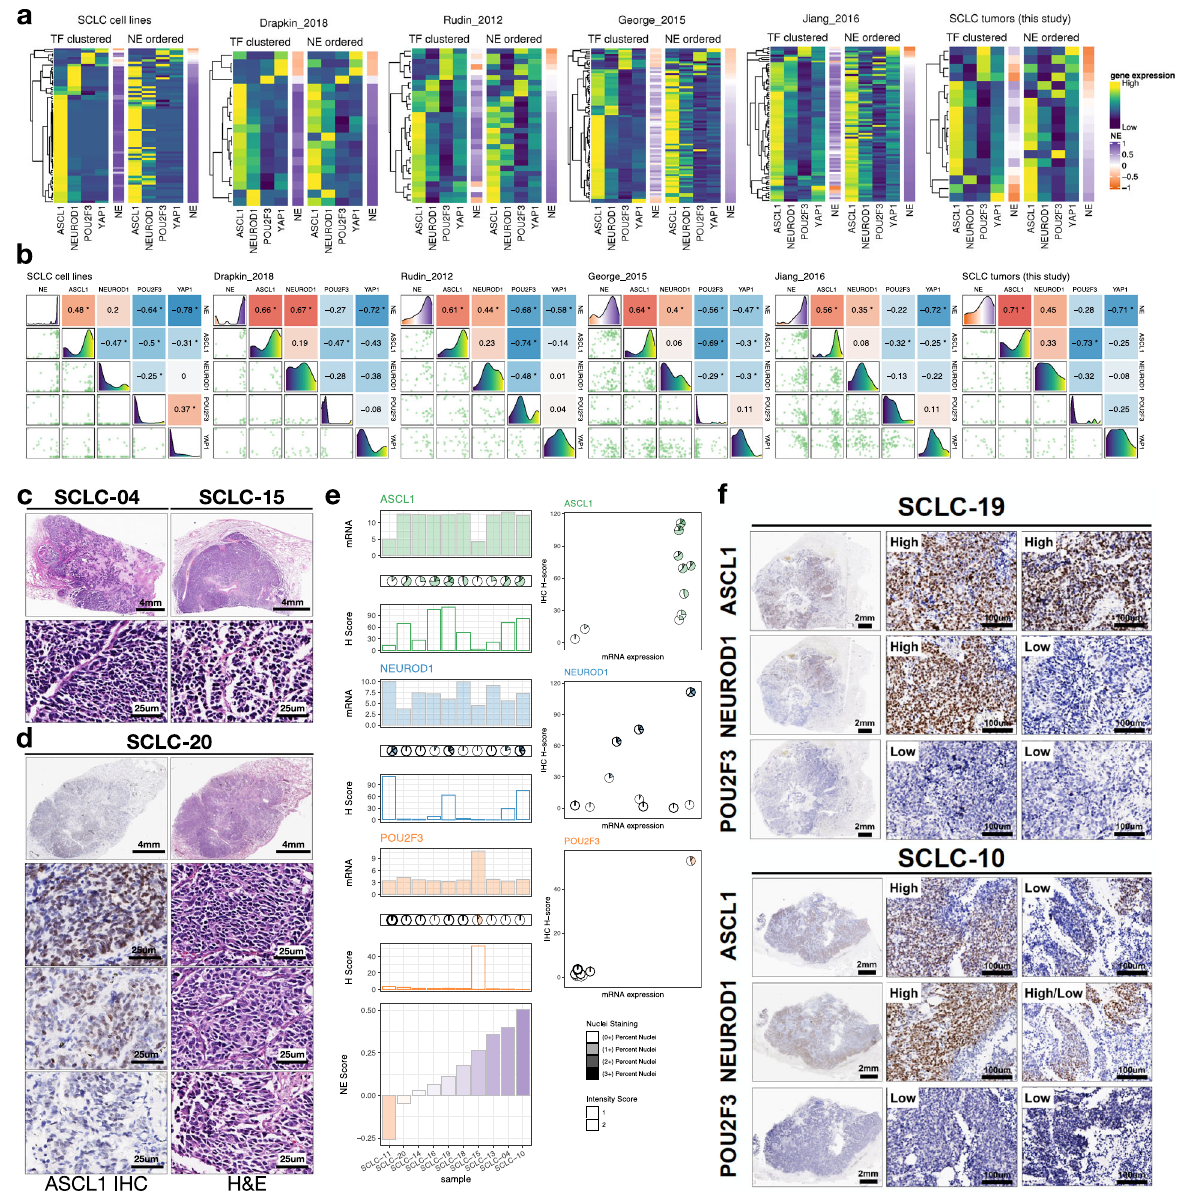
Fig. 1 NE score and SCLC molecular subtypes. a Heatmaps visualizing relative expression of molecular subtype-speci fi c TFs and NE scores. Two heatmaps were generated for each study, with one ordered by complete linkage hierarchical clustering of TFs and the other ordered by NE scores. Gene expression was z -score standardized for each sample. b Pairs plot for NE scores and molecular subtype-speci fi c TFs. Lower left panels are scatter plots showing a pairwise relationship between variables, diagonal panels are density plots showing the distribution of each variable and upper right panels are correlation coef fi cients from pairwise Pearson correlation. Refer to the top or right of each 5 × 5 matrix for subplot x or y axis variable labels. For example, for each data set, the fi rst subplot on the top row shows the distribution of NE scores from that data set, the scatterplot below it shows the relationship between NE score ( x axis value) and ASCL1 expression ( y axis value), and the Pearson correlation coef fi cient between NE score and ASCL1 expression is provided in the second cell of the top row. * p -value < 0.05. Note that in all studies: most samples have positive NE score; under TF-based classi fi cation, ASCL1 + subtype dominates; NE scores positively correlate with ASCL1 and NEUROD1 but negatively correlate with POU2F3 and YAP1 expression. c H&E staining of two high NE-score SCLC tumor samples showing classic SCLC morphology with dark nuclei, scant cytoplasm, and inconspicuous nucleoli. d ASCL1 IHC staining and H&E staining of a low NE-score SCLC tumor, showing variable morphology at different selected areas, where ASCL1-low areas appear to be more variant- like. e Quanti fi cations of TF expression from IHC staining or microarray pro fi ling, samples are ordered by increasing NE scores. f IHC of ASCL1, NEUROD1, and POU2F3 in two tumors that express both ASCL1 and NEUROD1. Two areas per tumor were selected for showing intratumoral heterogeneity in ASCL1 and NEUROD1 expression